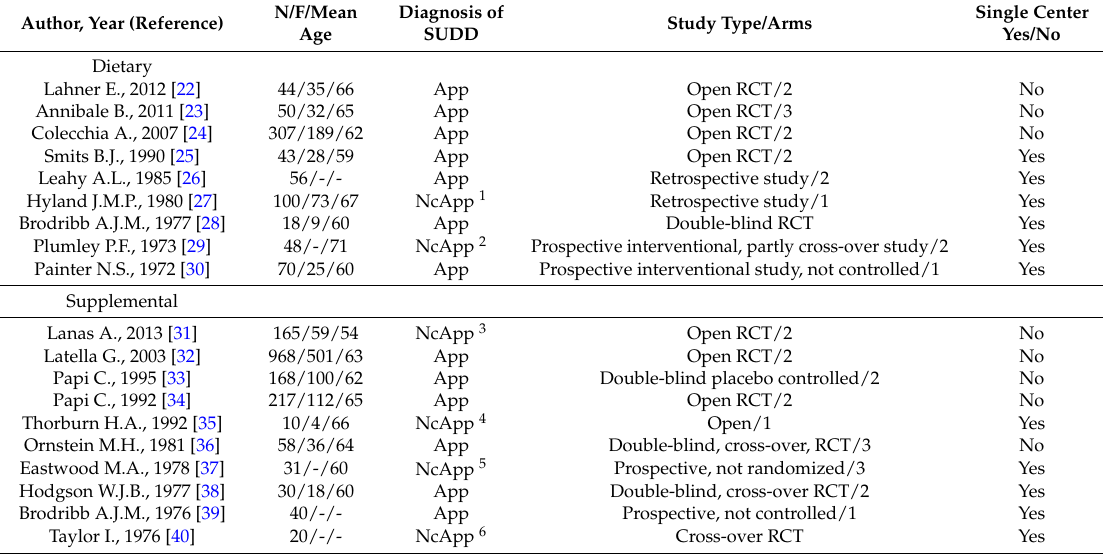
Table 2. Main characteristics of the 19 selected studies on fibers in symptomatic uncomplicated diverticular disease